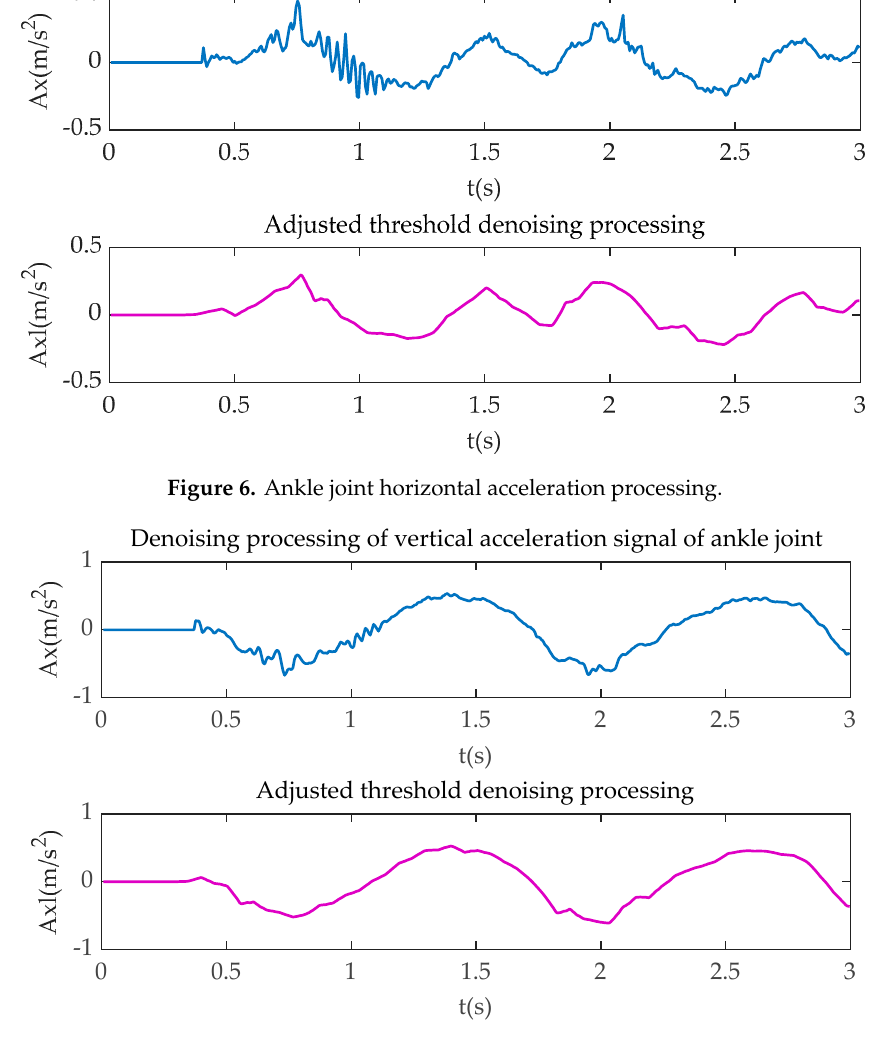
Figure 7. Ankle joint vertical acceleration processing.